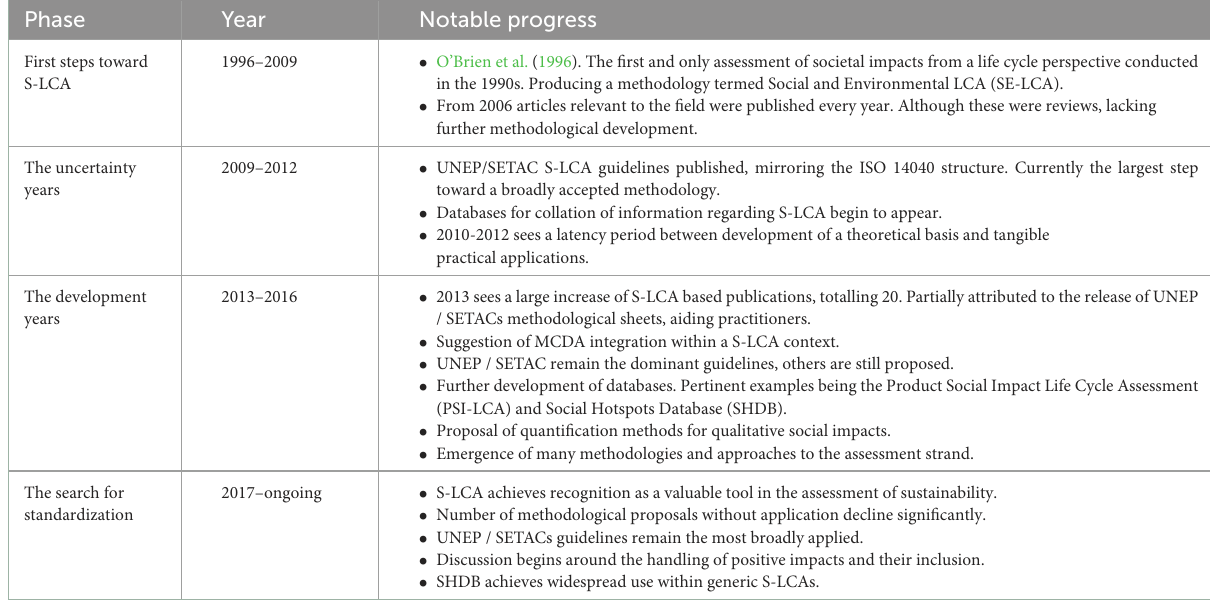
TABLE 1 Developmental stages of S-LCA or SIA and their associated points of notable progress. Phase